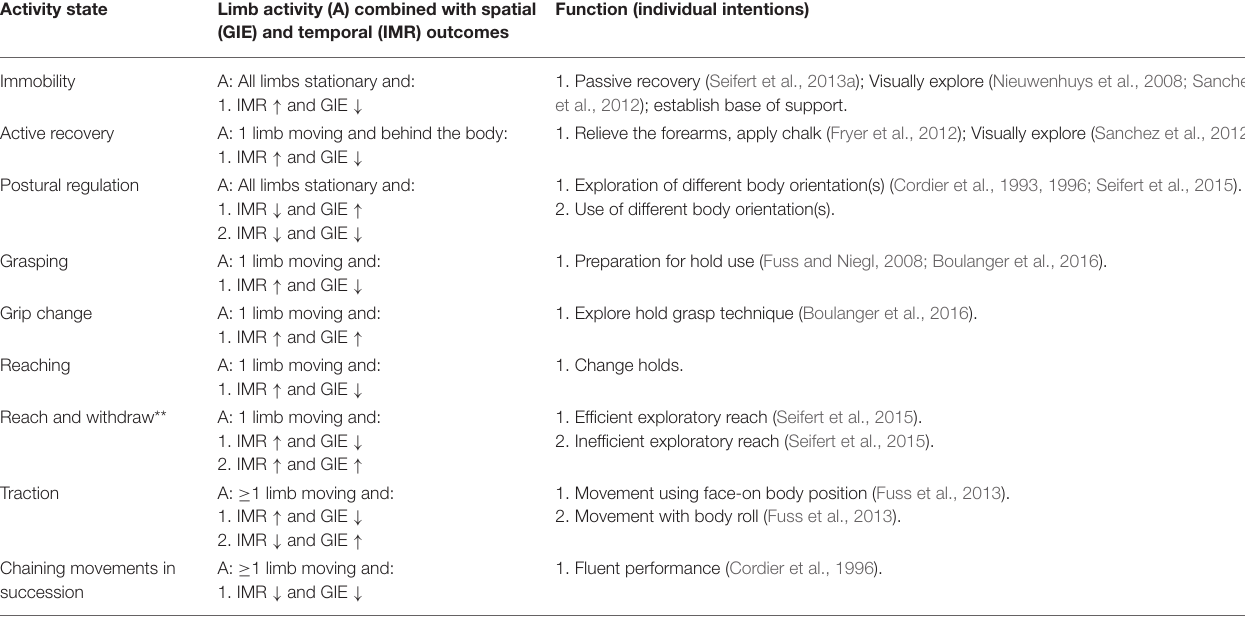
TABLE 2 | Relationships between spatiotemporal outcomes, discrete actions and climbers intentions. Activity